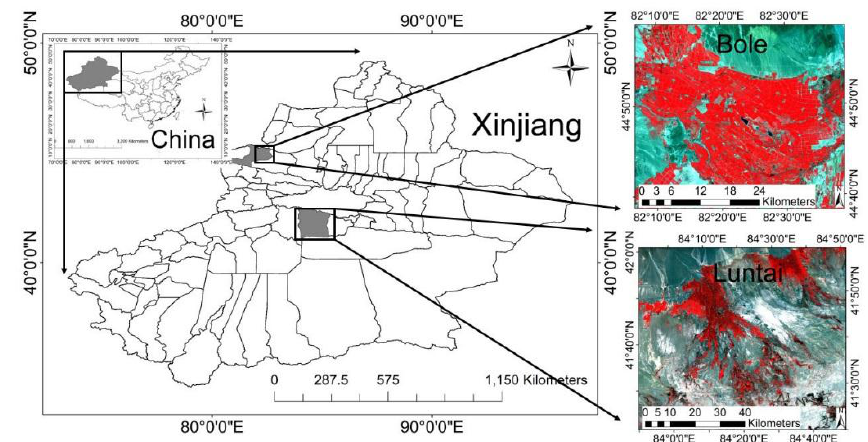
Figure 2. Locations of the study areas.